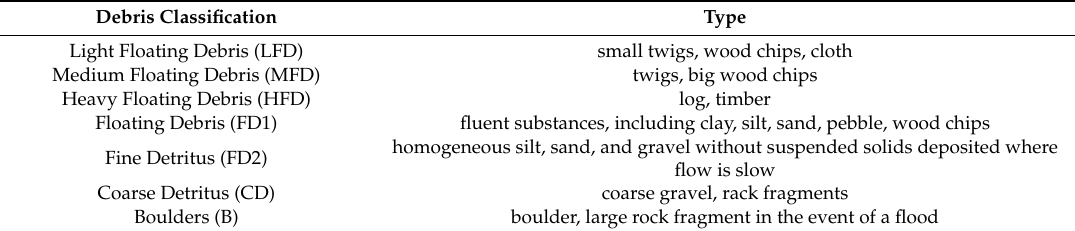
Table 1. Type of